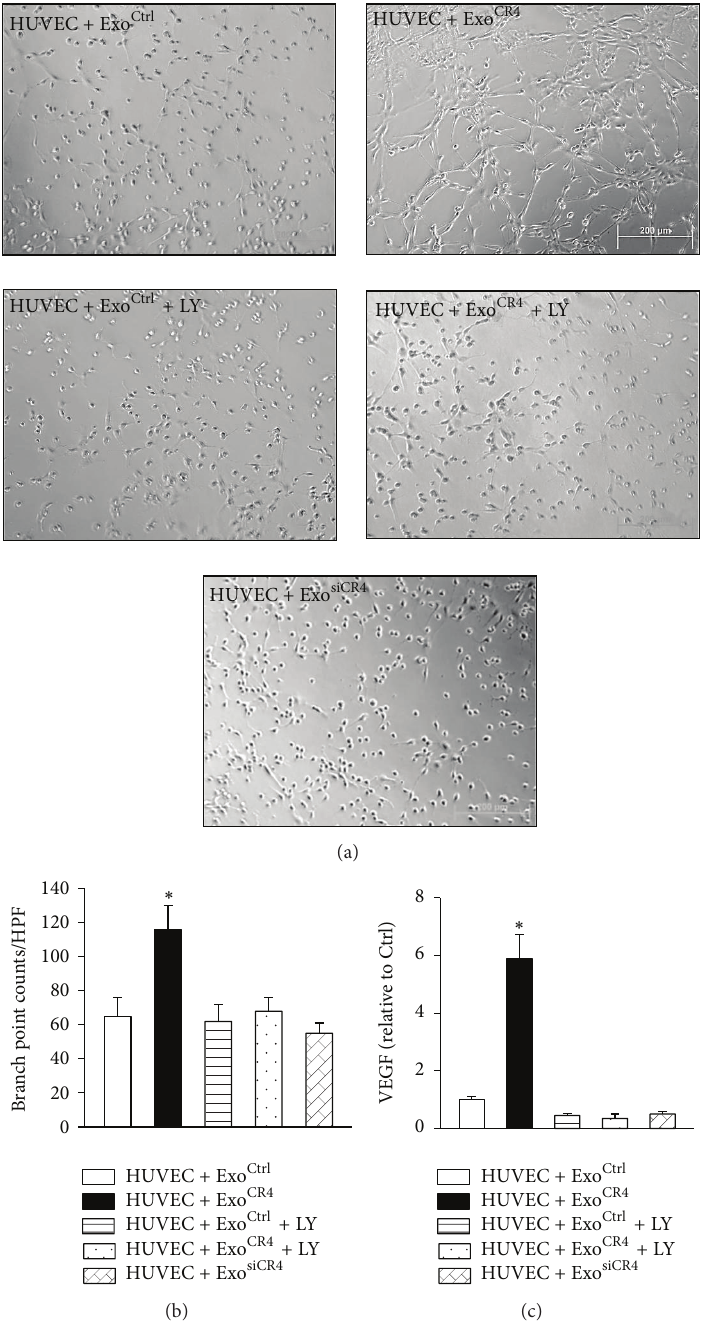
Figure 5: The in vitro angiogenic properties of MSC CR 4 -derived exosomes. (a) Induction of tube formation by MSC-derived exosomes in HUVEC. (b) Quantitative data of total branch points in various groups. (c) VEGF expression in various groups was analyzed by qPCR. ∗ 𝑃 < 0.05 versus Exo Ctrl . All values expressed as mean ± SEM, 𝑛 = 6 for each group. HUVEC + Exo Ctrl , HUVEC treated with MSC Ctrl - derived exosomes; HUVEC + Exo CR 4 , HUVEC treated with MSC CR 4 -derived exosomes; HUVEC + Exo Ctrl + LY, HUVEC + Exo Ctrl treated with LY294002 (a PI3K inhibitor); HUVEC + Exo CR 4 + LY, HUVEC + Exo CR 4 treated with LY294002; HUVEC + Exo siCR 4 , HUVEC treated with MSC siCR 4 -derived